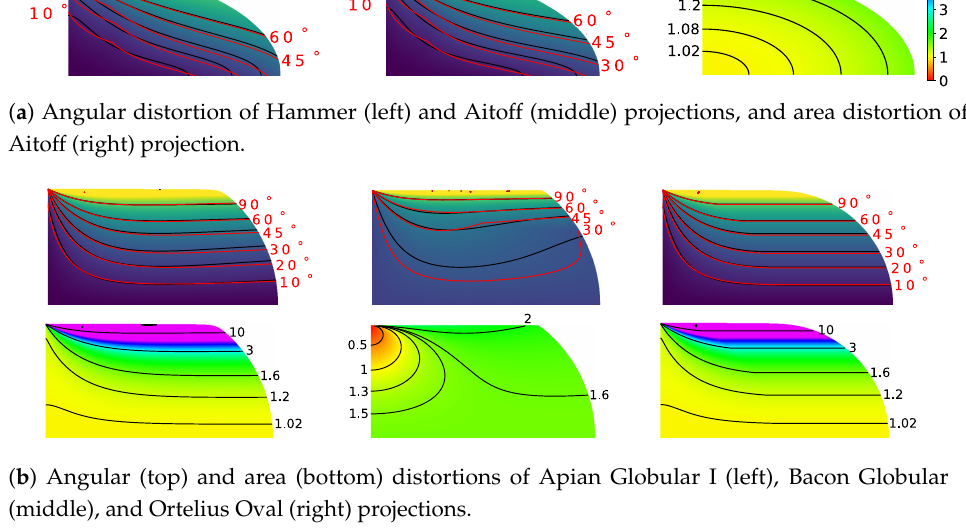
(middle), and Ortelius Oval (right) projections. Figure 15. Comparison of distributions and contours of the FWD–GCA metric for evaluating similar map